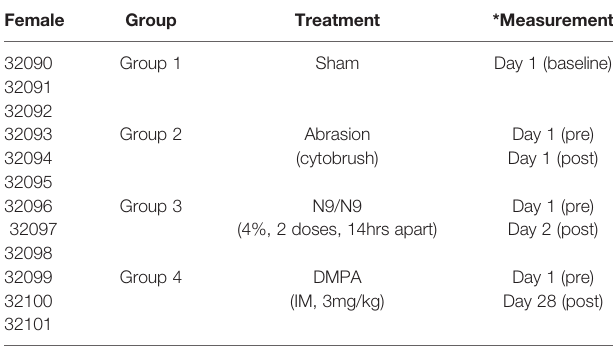
TABLE 1 | Female macaques: assigned groups and treatment